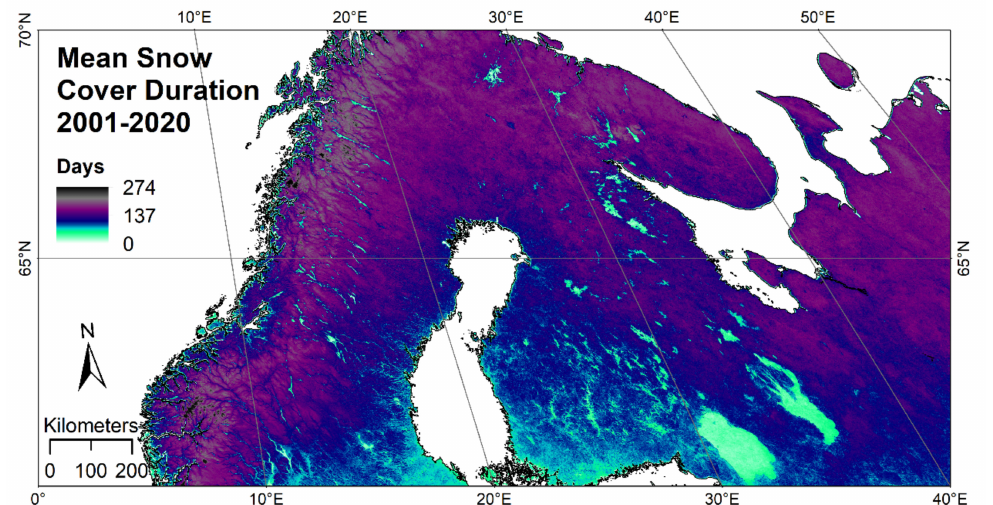
Figure 4. Arithmetic mean of the yearly snow cover duration for the hydrological years 2001 to 2020 for the tiles h18v02 and h19v02.